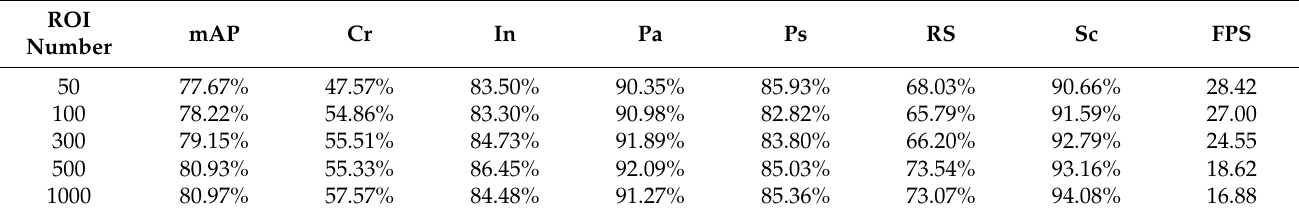
Table 5. Detection results of different ROI